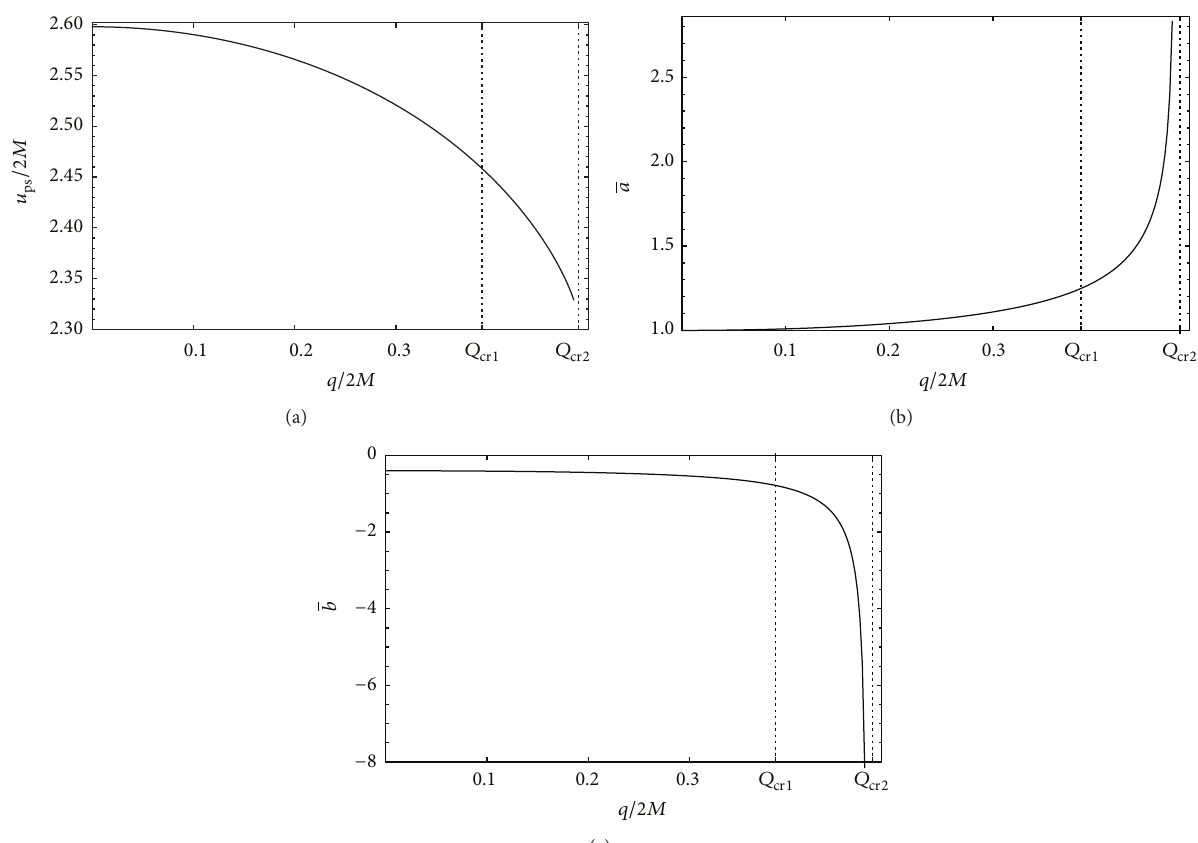
and the strong deflection limit coefficients 𝑎 and 𝑏 ps